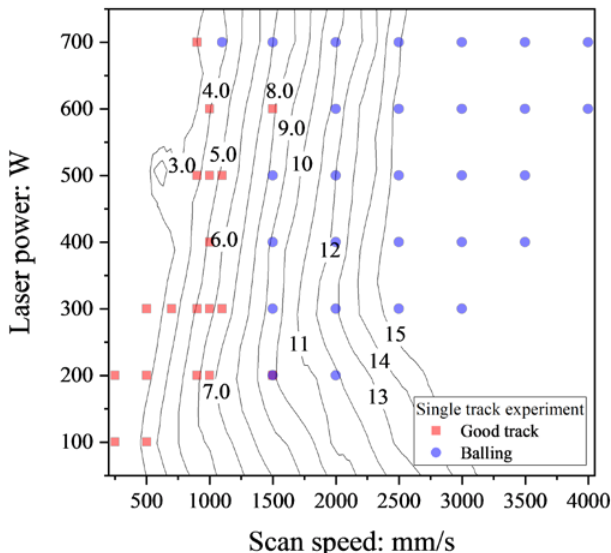
Figure 7. The contour diagram of L / D obtained by the FEM analysis and the classification of the balling and the good track of the single-track experiments. The boundary between the good track and the balling is between about L / D = 4 and 9; hence, the L / D is a good predictor for the balling.